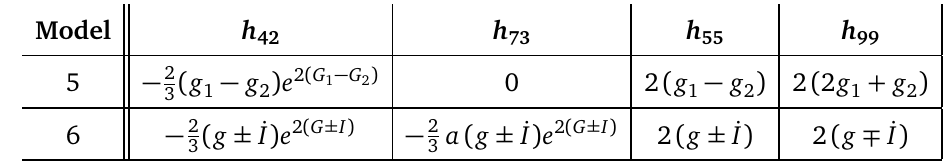
Table 2: Nonzero elements of the Hamiltonian densities for models 5-6. Also, a is a